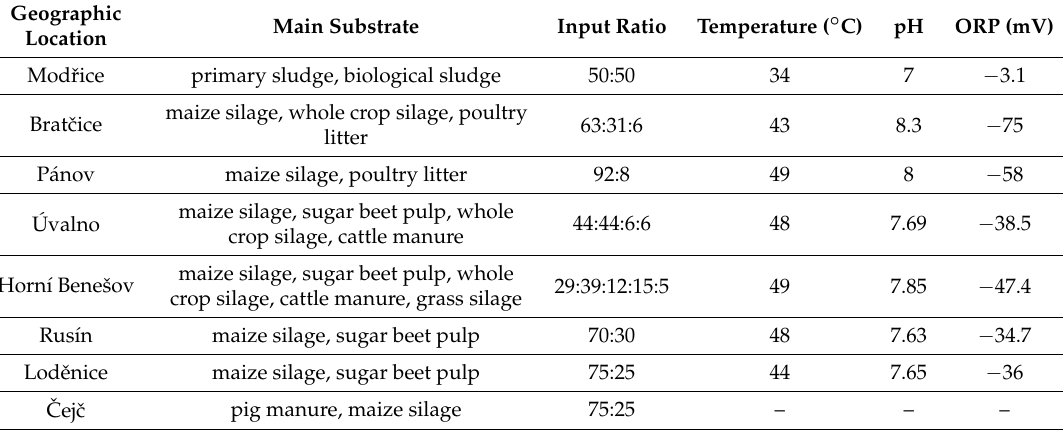
Table 1. Characteristics of evaluated anaerobic digesters (Reproduced with permission of Kushkevych